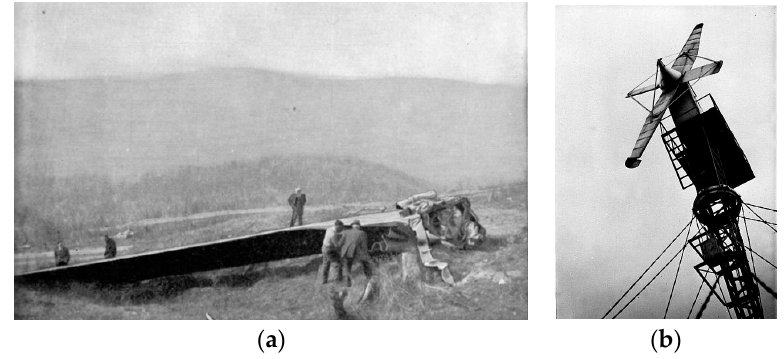
Figure 1. Early history of wind turbines: ( a ) Failed blade of Smith wind turbine of 1941 (Reprinted from [10]; and ( b ) Gedser wind turbine (from [11]).